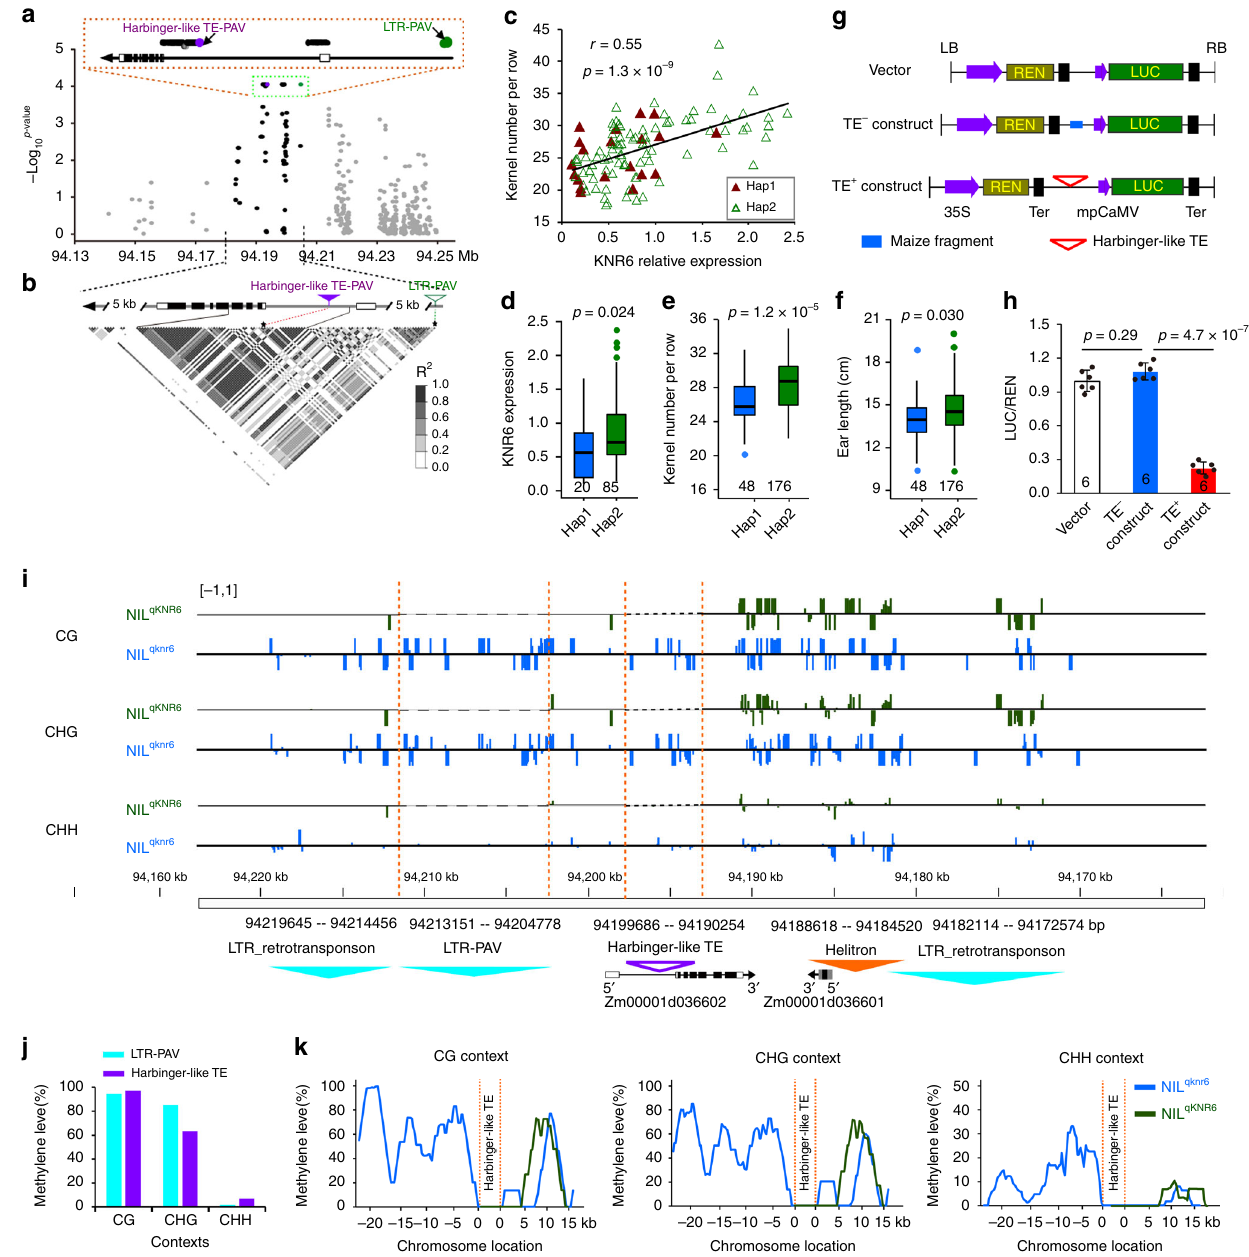
Fig. 3 Association mapping and DNA methylation assay. a Associations of 433 DNA polymorphisms at the KNR6 locus with KNR in 224 diverse maize inbred lines. Each dot represents a polymorphic site. Black dots, polymorphic sites within 10_kb fl anking sequences of KNR6 ; purple dot, the Harbinger -like TE PAV; green dot, the LTR-TE PAV; gray dots, others. Black rectangles, exons; white rectangles, UTRs. The signi fi cance level of the associated site, p = 0.05/the number of polymorphic sites. b The pattern of linkage disequilibrium for polymorphic sites. Asterisks, two PAV sites in the LD block. c Pearson correlation between KNR6 expression levels and KNR. The p value is determined by the two-tailed Student ’ s t test. d Expression levels of KNR6 in 20 Hap1 lines and 85 Hap2 lines using qPCR, with three biological replicates in each case. e , f Box-and-whisker plots of KNR ( e ) and EL ( f ) for 48 Hap1 lines and 176 Hap2 lines. Each box represents the median and interquartile range. Whiskers extend to maximum and minimum values. Signi fi cance of difference is estimated by the one-way ANOVA. g A diagram of the constructs. TE + construct includes a 5570_bp fragment containing the Harbinger -like TE; TE − construct represents the 567_bp sequence lacking the TE . h Luciferase activity in maize leaf protoplasts. Luciferase activity is measured with three biological replicates, each with two technical replicates. Data are normalized with respect to the average value of the empty construct, and are shown as means ± s.d. p Value is estimated by the one-way ANOVA. i Visualization of the DNA methylation regions. DNA methylation levels were measured by bisul fi te sequencing, and the methylation status was illustrated using the Integrated Genome Viewer. The upper and lower panels show the sense and antisense strands, respectively. j DNA methylation level of the three contexts in the long terminal repeat (LTR) retrotransposon and the Harbinger -like TE. k Methylation patterns of the fl anking regions of the Harbinger -like TE in both parent lines. The methylation levels of CG, CHG, and CHH were scanned using a window size of 200 bp and a step size of 100 bp. Source data underlying Fig. 3e – h are provided in a Source Data fi